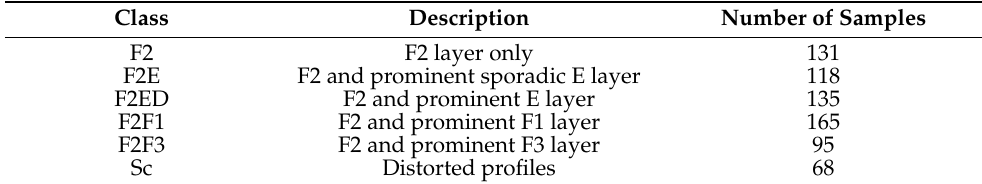
Table 1. Statistics of different classes for the modeling. Class